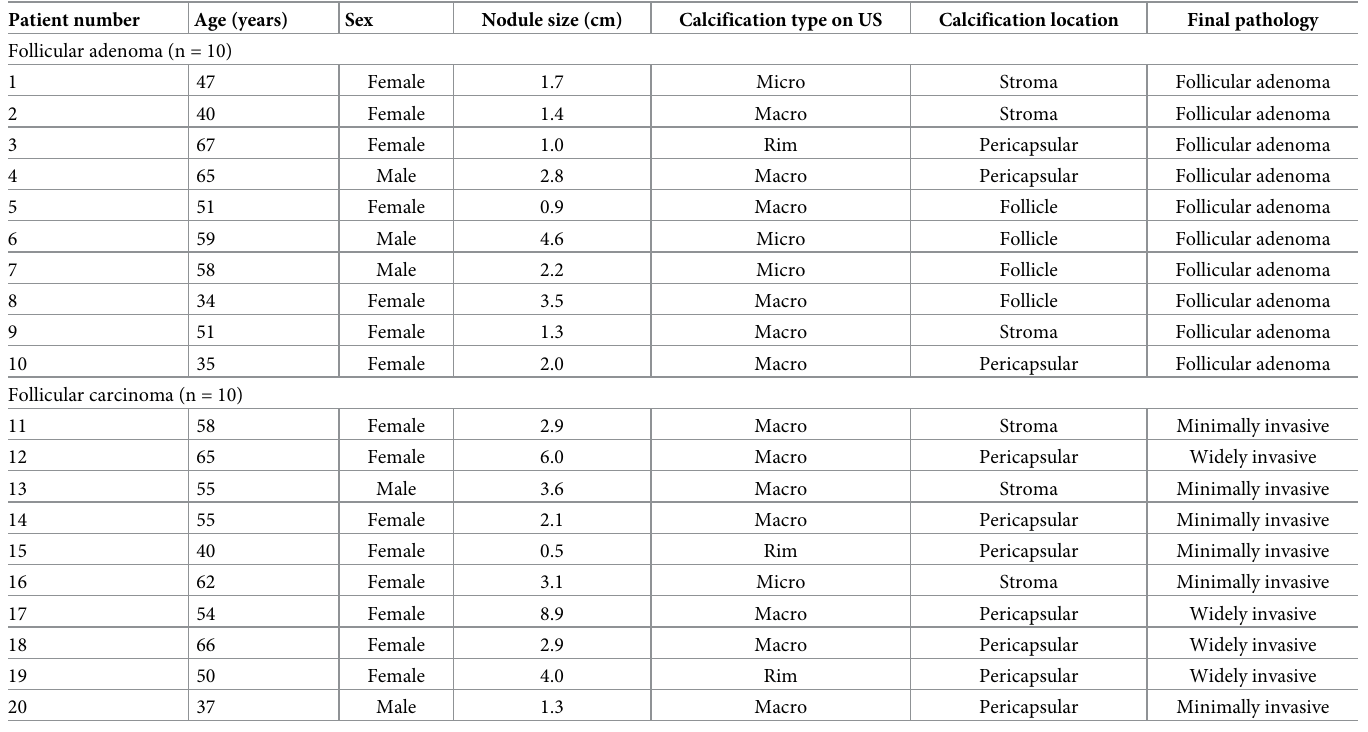
Table 4. Characteristics of the patients with follicular neoplasm with